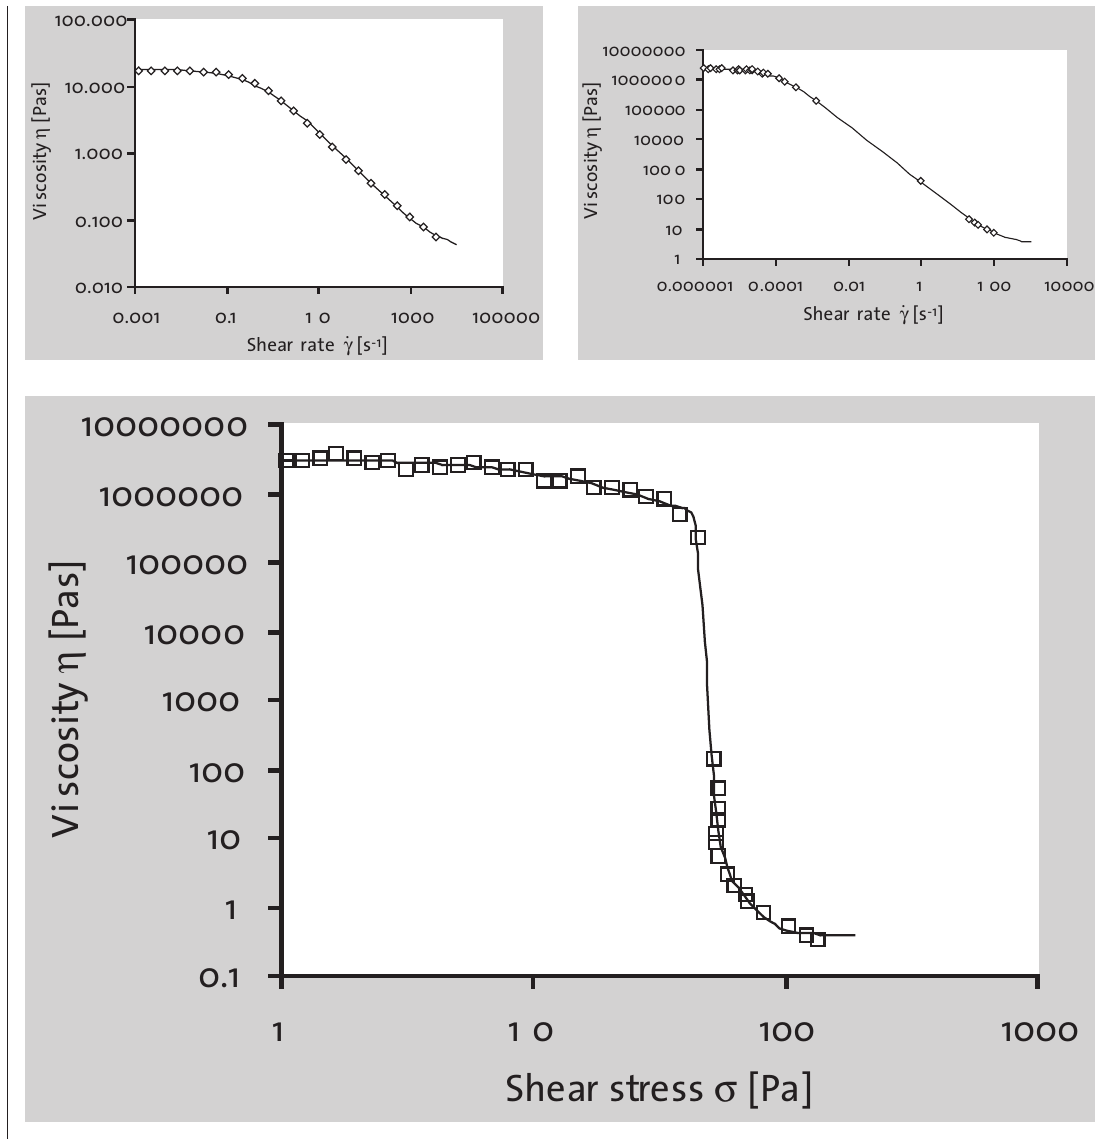
Figure 9 (left): Flow curve for SUA1 non-Newtonian standard liquid, fitted to the Cross model with